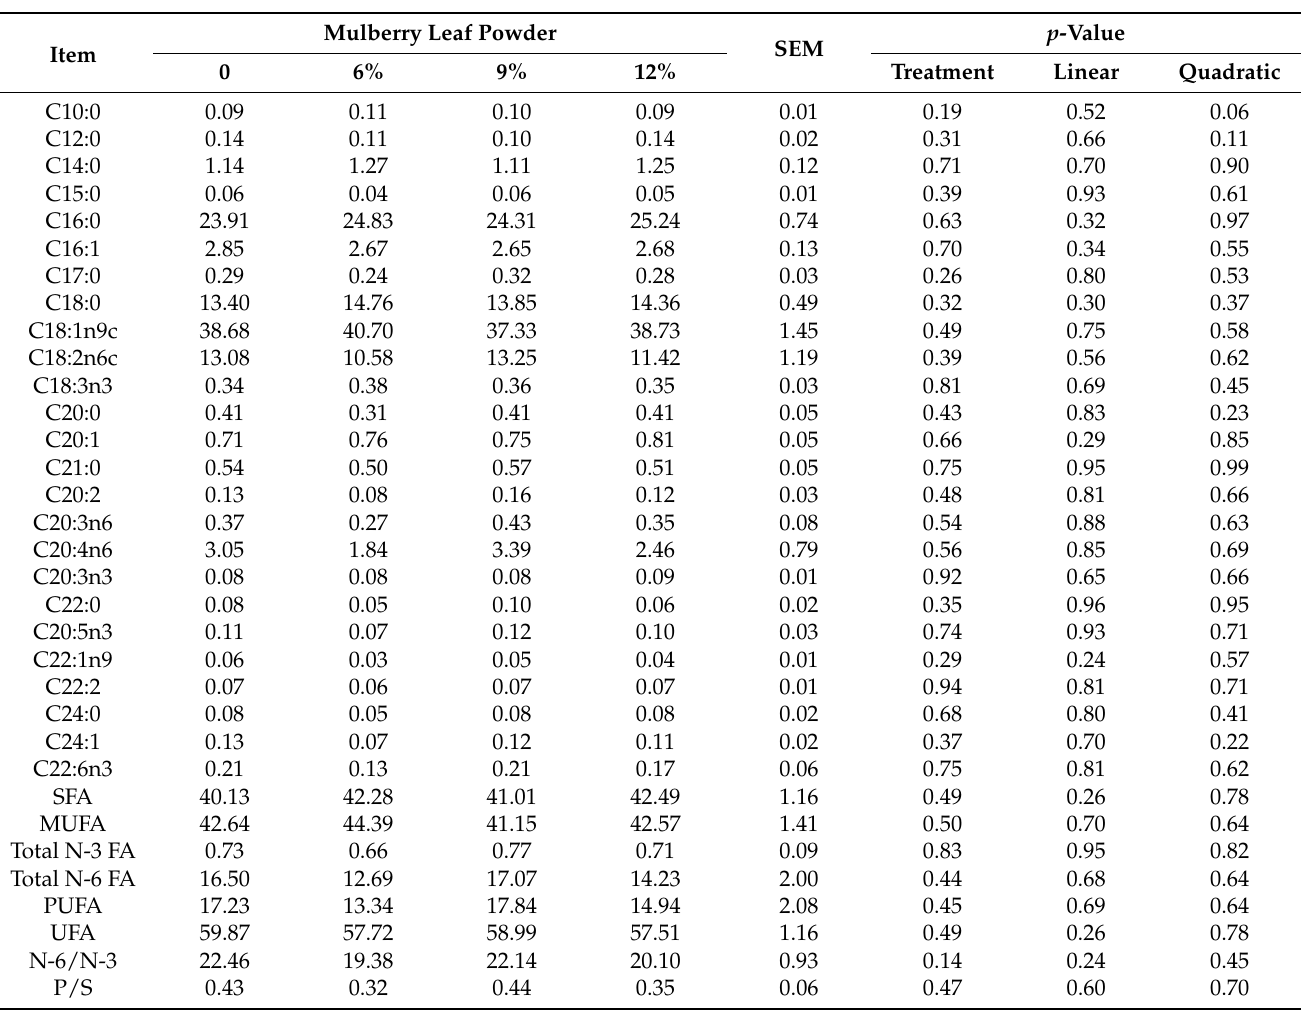
Table 7. Effect of mulberry leaf powder of varying levels on lipid profile in finishing